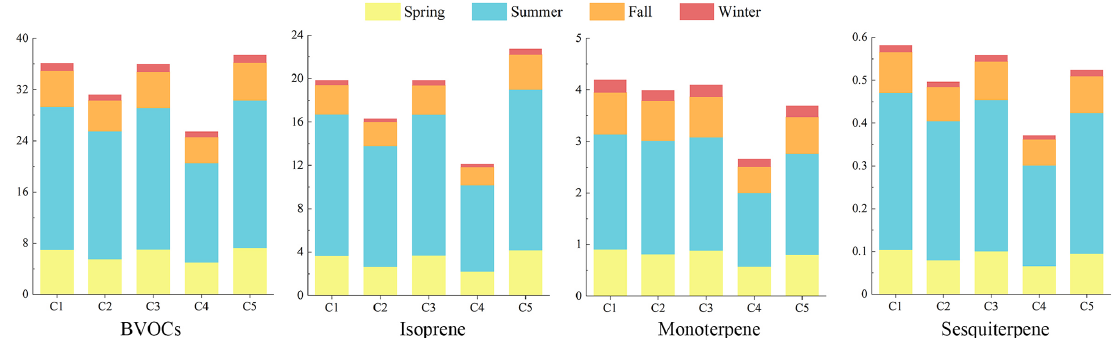
Figure 3. Seasonal emissions of isoprene, monoterpenes, sesquiterpenes, and total BVOCs of each case in China. Unit is teragrams.